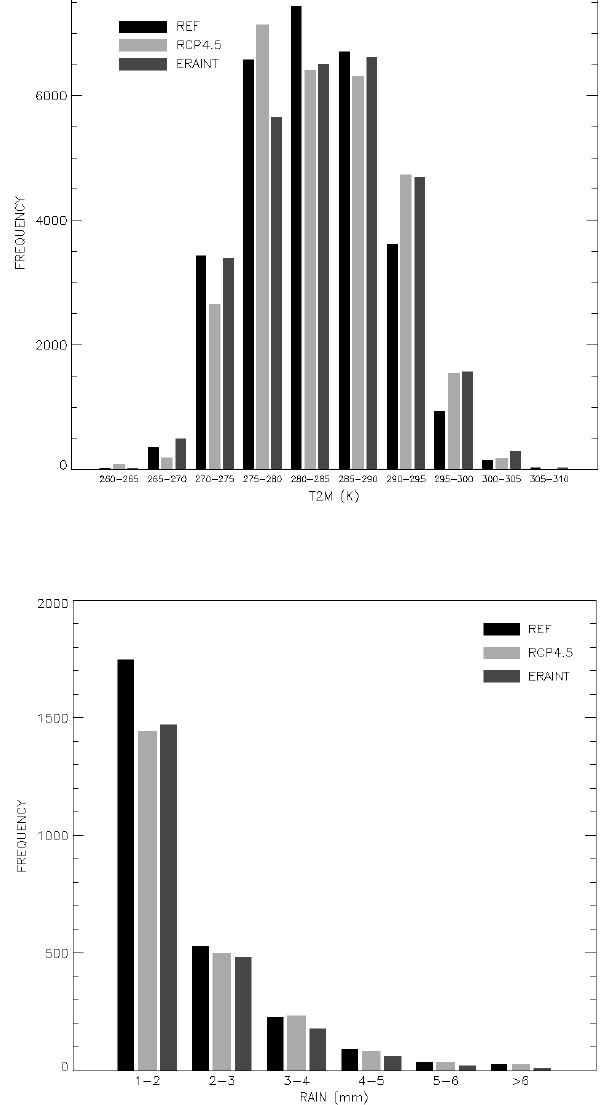
Figure 7. Histogram of hourly mean 2m air temperatures (top panel) and rainfall amounts (lower panel) for all scenarios.